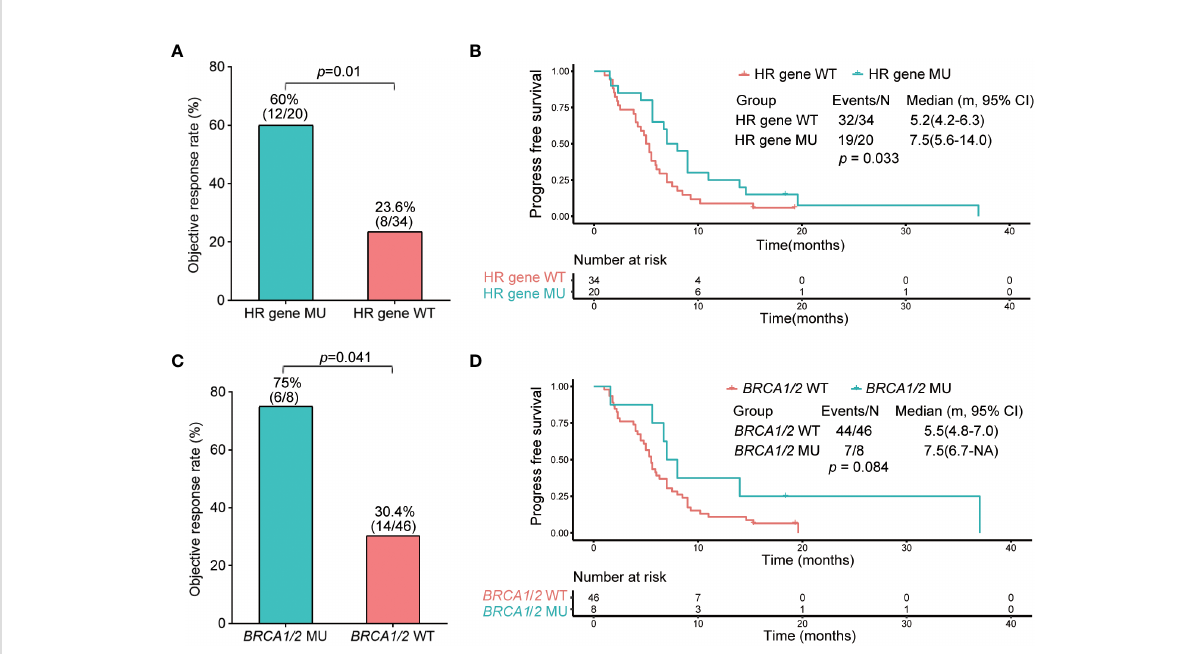
FIGURE 3 Objective response rate and progression-free survival analysis of HR and BRCA1/2 gene wild type and mutated groups. (A) Objective response rate of HR gene wild type and mutated groups. (B) Kaplan – Meier analysis of progression-free survival of HR gene wild type and mutated groups. (C) Objective response rate of BRCA1/2 gene wild type and mutated groups. (D) Kaplan – Meier analysis of progression-free survival of BRCA1/2 gene wild type and mutated